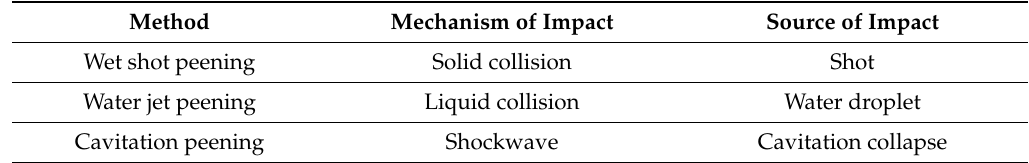
Table 1. Colloquial terms for water jet peening